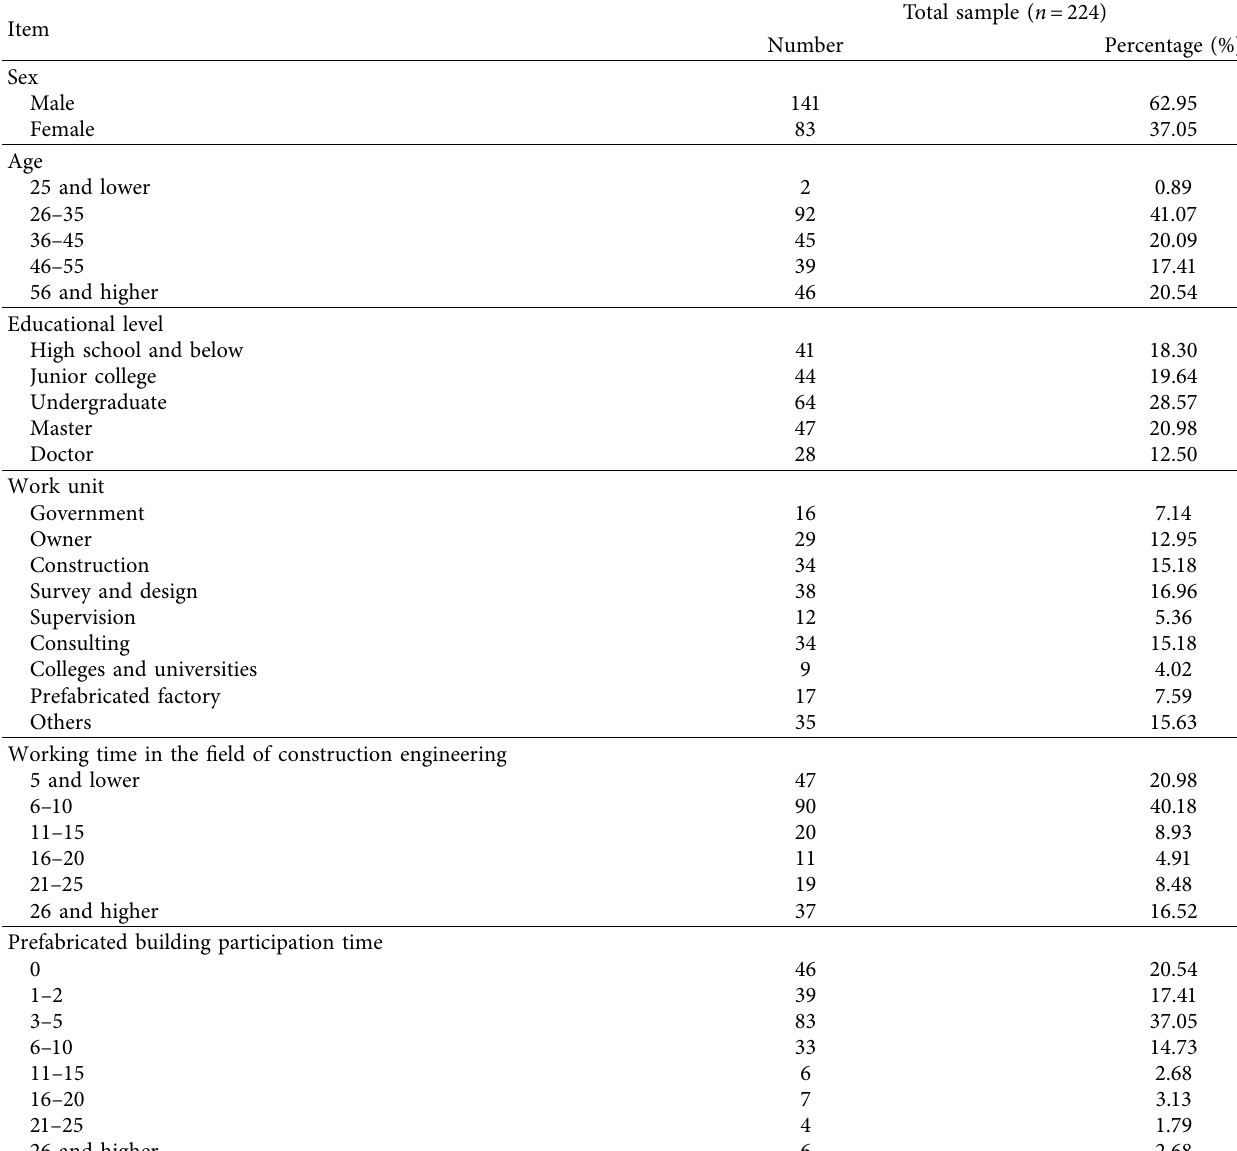
Table 4: Background information of